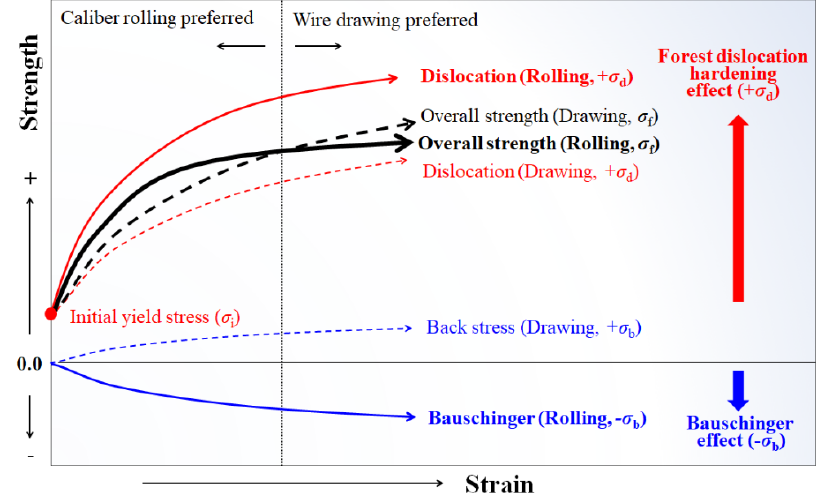
Figure 14. Schematic of the variation in strength of the drawn and caliber-rolled wires with strain considering forest dislocation hardening and BE.